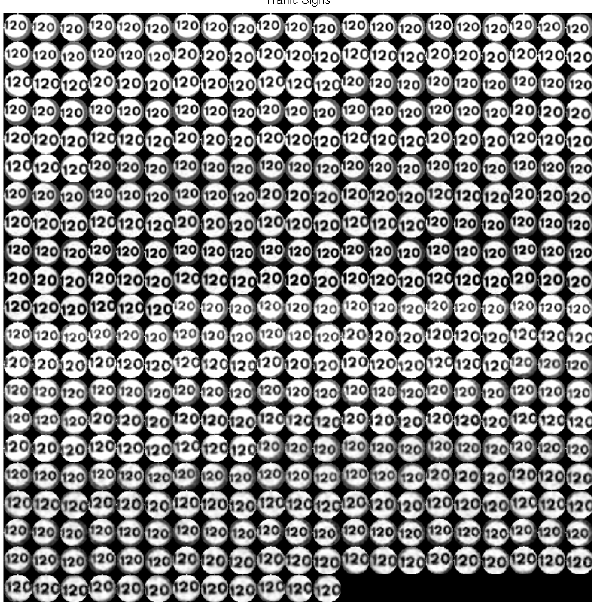
Figure 8. Transformations applied to a speed limit sign to generate the